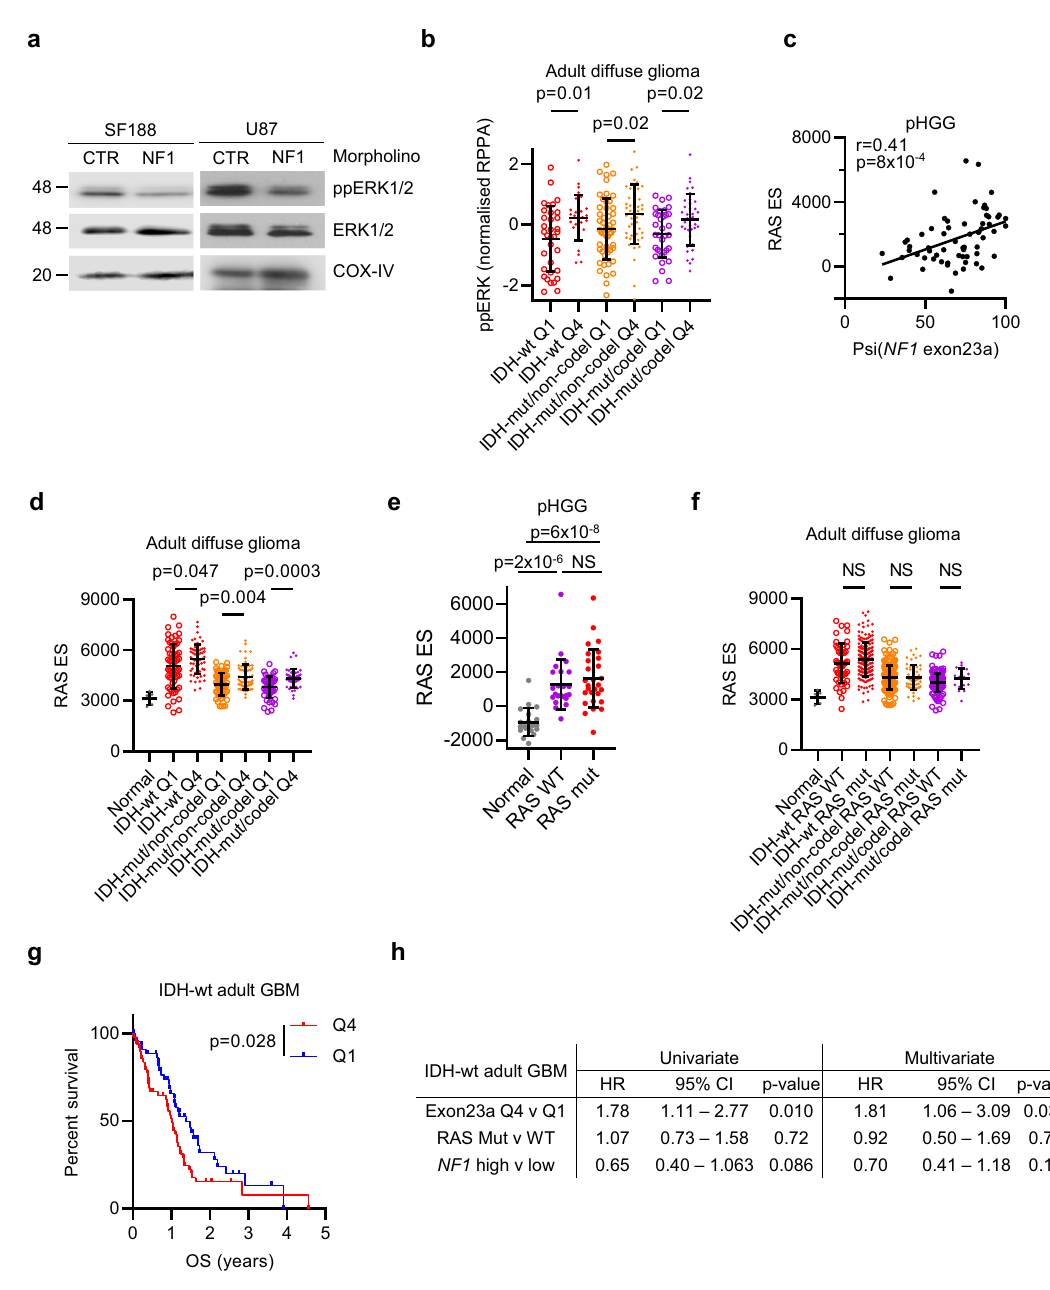
Fig. 5 Activation of RAS/MAPK by NF1 exon23a inclusion in HGG. a Western blot of cells harvested 48 h post transfection with control or NF1 exon23a- speci fi c morpholinos. Gels are representative of two experiments. b Normalised reverse-phase protein array (RPPA) signal for phospho-ERK (ppERK) for adult diffuse glioma Q1 and Q4 patients in each subgroup. n: IDH-wt Q1 = 34, Q4 = 30; IDH-mut/non-codel Q1 = 50, Q4 = 51; IDH-mut/codel Q1 = 34, Q4 = 37. Bars show mean ± standard deviation. c Plot of NF1 exon23a inclusion (psi) and RAS pathway activation score (RAS ES; enrichment score, determined from single-sample GSEA [ssGSEA]) in pHGG. r: Pearson correlation. d RAS pathway activation ssGSEA score for the normal brain ( n = 5) and adult diffuse glioma patients that are in quartile 1 (Q1) and quartile 4 (Q4) of NF1 exon23a inclusion for each subgroup. n: IDH-wt Q1 = 60, Q4 = 58; IDH- mut/non-codel Q1 = 63, Q4 = 63; IDH-mut/codel Q1 = 45, Q4 = 43. Bars show mean ± standard deviation. e RAS pathway activation ssGSEA score in normal brain ( n = 20) or pHGG that is RAS/MAPK WT ( n = 23) or mutant ( n = 28). Bars show mean ± standard deviation. f RAS pathway activation ssGSEA score for adult diffuse glioma subgroups that are RAS/MAPK WT or mutant. n: IDH-wt WT = 27, mut = 216; IDH-mut/non-codel WT = 165, mut = 105; IDH-mut/codel WT = 165, mut = 105. Bars show mean ± standard deviation. g Kaplan – Meier survival plot of (NF1-WT) IDH-wt GBM patients that are in the top (Q4, n = 50) or bottom (Q1, n = 47) quartile of NF1 exon23a inclusion. h Univariate and multivariate Cox proportional-hazards survival analysis of adult IDH-wt GBM accounting for NF1 exon23a inclusion (Q4 vs Q1), RAS/MAPK pathway mutation, and NF1 expression. HR hazard ratio, CI con fi dence interval. Statistical tests: t ( b , c , d , f ), Brown – Forsythe ANOVA with Dunnett ’ s T3 multiple comparisons test ( e ), Gehan – Breslow – Wilcoxon ( g ), Cox proportional-hazards ( h ). NS not signi fi cant. Source data are provided as a Source Data fi